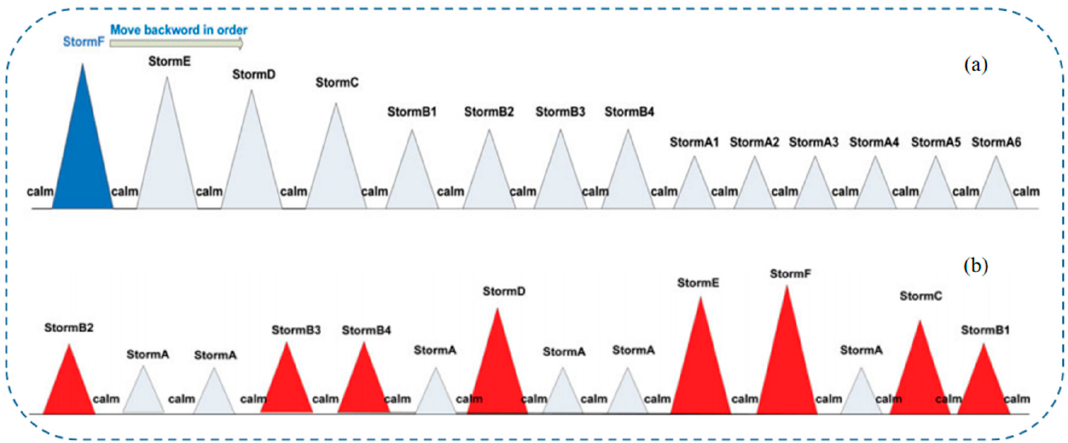
Figure 7. Determination of position of storm F: ( a ) An illustrative load mode when storm F is in the first position; ( b ) The resulting standardised load-time history [17].